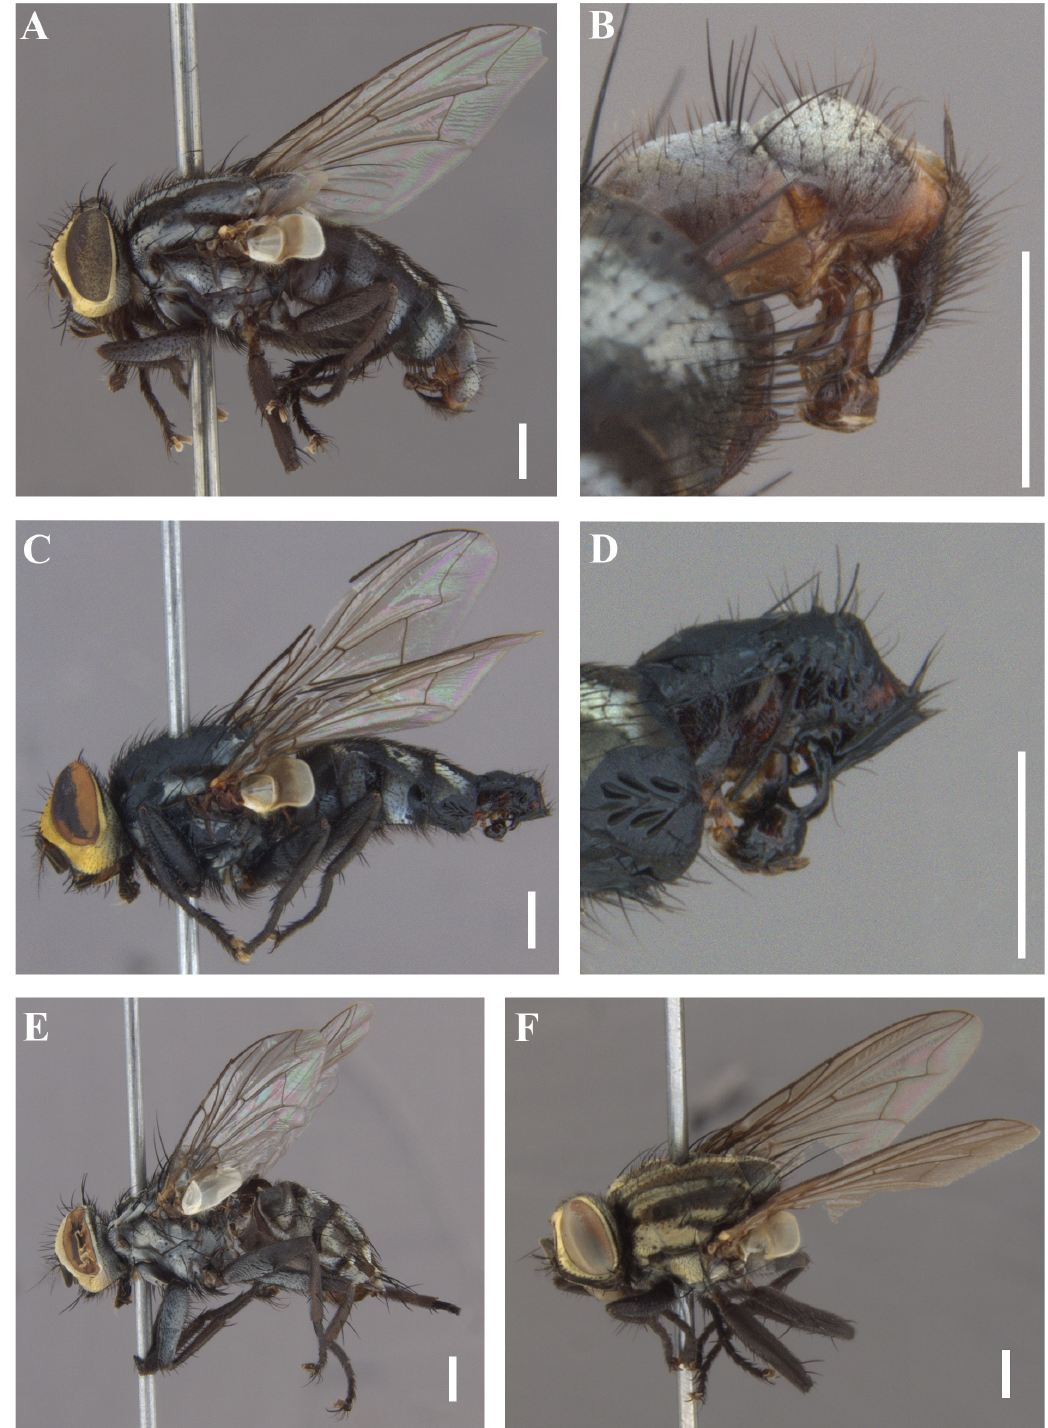
Fig. 3. Dexosarcophaga spp., male habitus and terminalia. A–B . Dexosarcophaga phoenix sp. nov., holotype (MNRJ [lost]). A . Habitus, lateral view. B . Terminalia, lateral view. C–D . Dexosarcophaga jandainae sp. nov., ♂, paratype (MZUSP [lost]), Brazil, Mato Grosso, Chapada dos Guimarães. C . Habitus, lateral view. D . Terminalia, lateral view. E . Dexosarcophaga patiuorum sp. nov., ♂, holotype (MNRJ [lost]), habitus, lateral view. F . Dexosarcophaga limon sp. nov., ♂, holotype (INBio [lost]), habitus, lateral view. Scale bars = 1.0